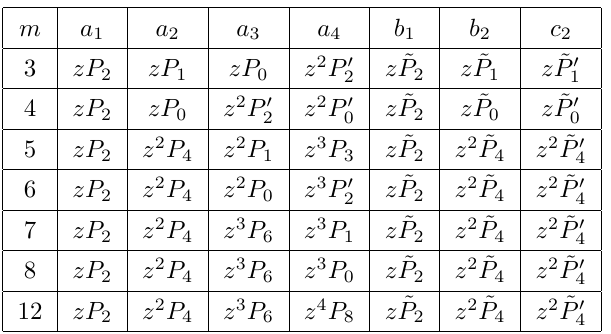
Table 3 . Leading behavior of the sections a i ; b i ; c i in z on a curve C with C Single curve NHCs with